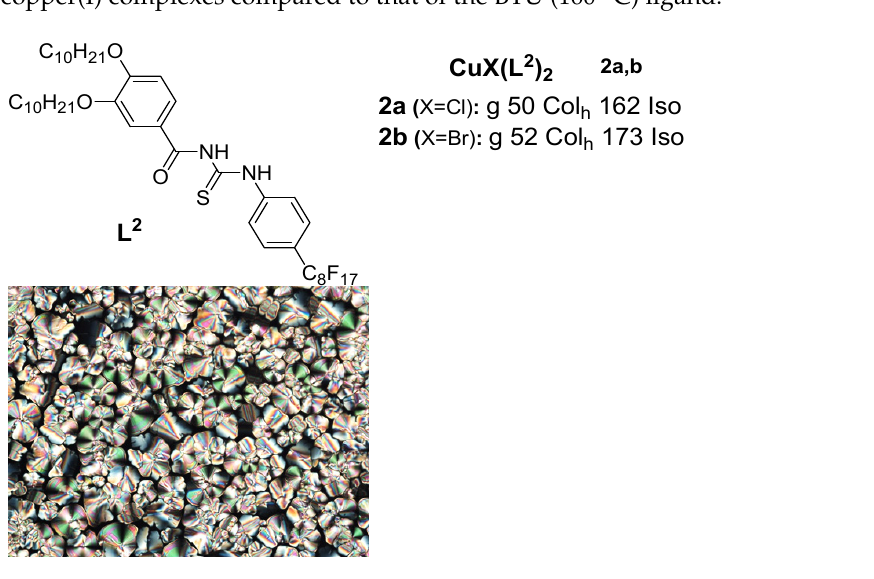
Figure 2. Copper(I) complexes with benzoylthiourea ligands. Transition temperatures are in °C. Inset: POM image of the Col h phase of 2a at 85 °C [35].